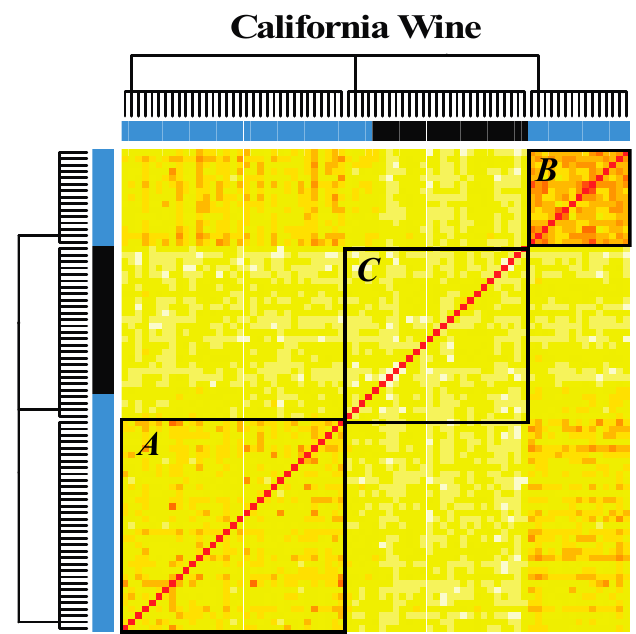
Figure 3. Heat map for the 75 characteristics of the Malbec wines from California. The heat map is computed using DCG and the mutual entropy distance measure (see text for details). Chemical and sensory characteristics are highlighted in blue and black, respectively. Three subgroups of those characteristics are identified, and labeled as A, B and C on the heat map. The color scale yellow-red used to represent the heat map corresponds to the interval [0,1] for the mutual entropy, with red mapping to 0 and yellow mapping to 1.